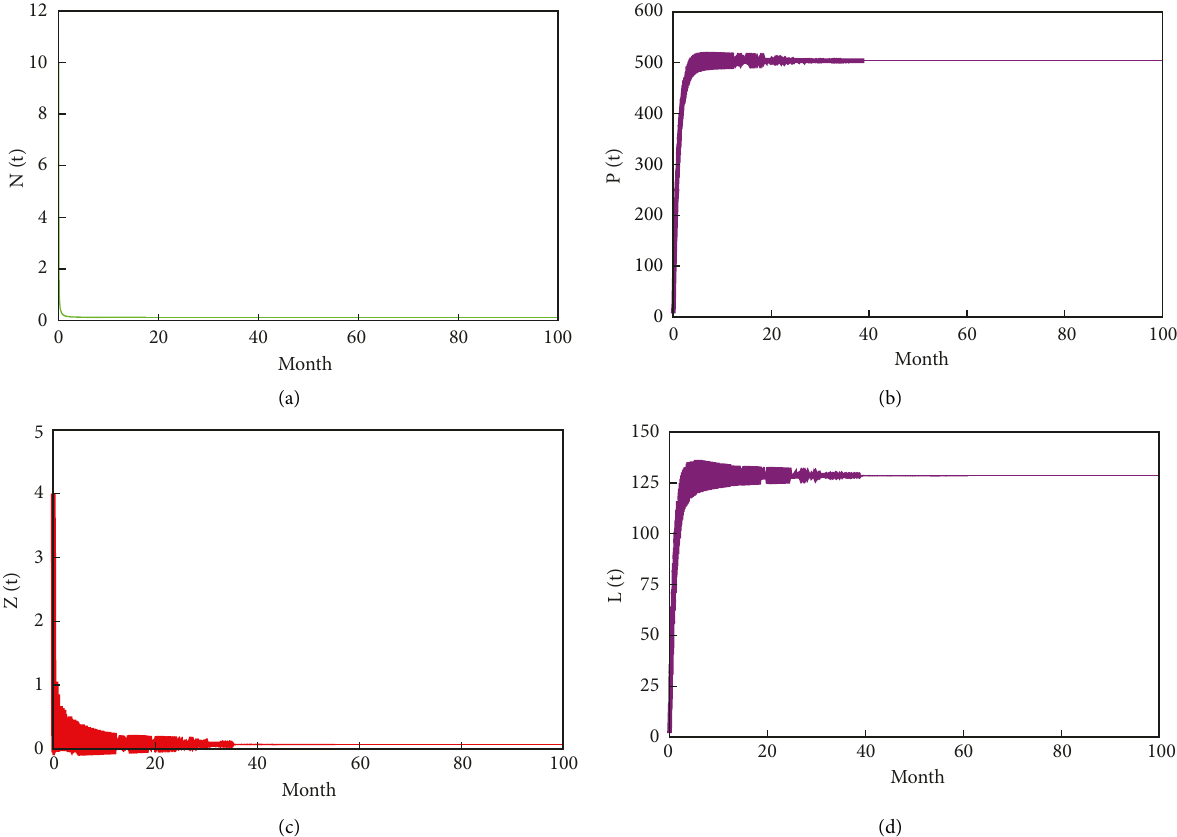
Figure 5: Time series plot of (a) nutrients; (b) phytoplankton; (c) zooplankton; (d) Limnothrissa miodon for system (2) for model (2) with b � c � 0 and assumed initial condition: N ( 0 ) � 10 , P ( 0 ) � 7 , Z ( 0 ) � 4 ,L ( 0 ) � 2 using the default parameter